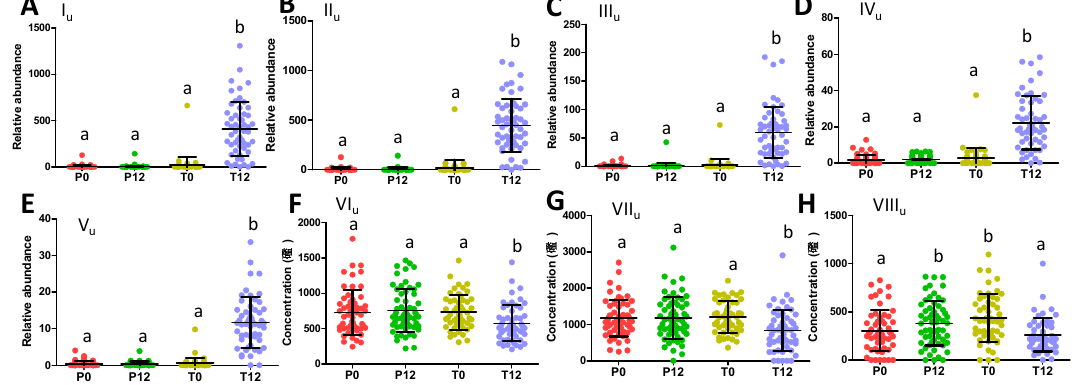
Figure 4. Distribution of GTP-related urine metabolites in 4 treatment groups. ( A ) Relative abundance of 5-(dihydroxyphenyl)- γ -valerolactone sulfate (I u ). ( B ) Relative abundance of 5-(dihydroxyphenyl)- γ -valerolactone sulfate (II u ). ( C ) Relative abundance of 5-(dihydroxyphenyl)- γ -valerolactone glucuronide (III u ). ( D ) Relative abundance of methyl epicatechin sulfate (IV u ). ( E ) Relative abundance of methyl epigallocatechin glucuronide (V u ). ( F ) Concentration of phenylacetylglutamine (VI u ). ( G ) Concentration of hippuric acid (VII u ). ( H ) Concentration of indoxyl sulfate (VIII u ). (Labels a and b indicate whether statistical difference ( p < 0.05) between 2 sample groups from one-way ANOVA and Tukey’s multiple comparison tests.).